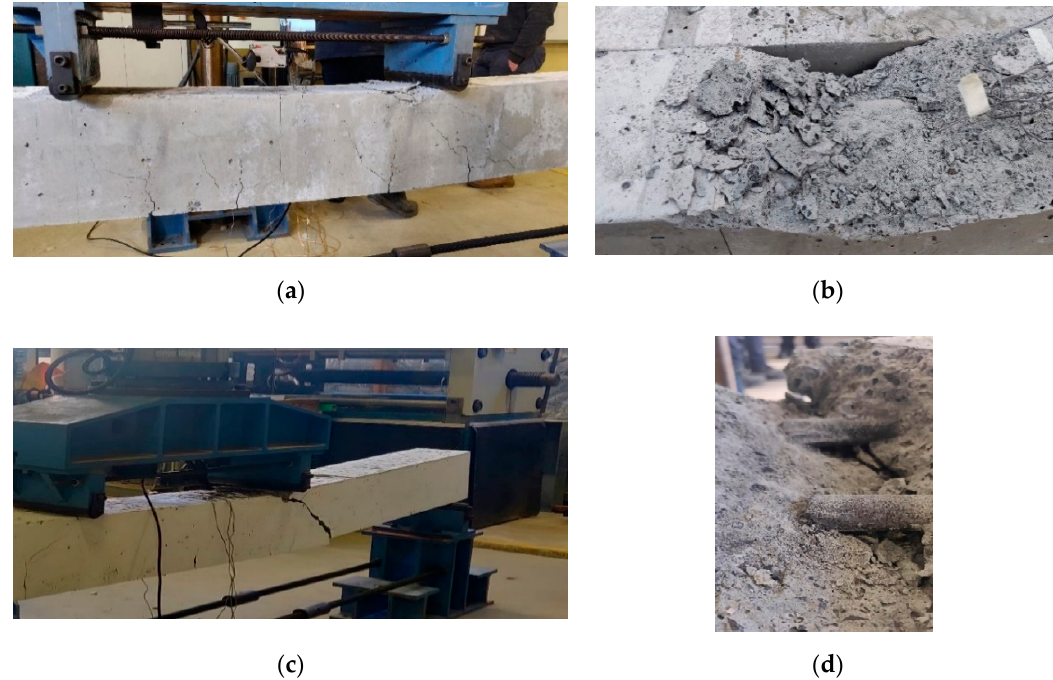
Figure 6. ( a ) Cracks at the constant moment zone; ( b ) Shear crack; ( c ) Concrete crushing; ( d ) Rupture of compression bars.